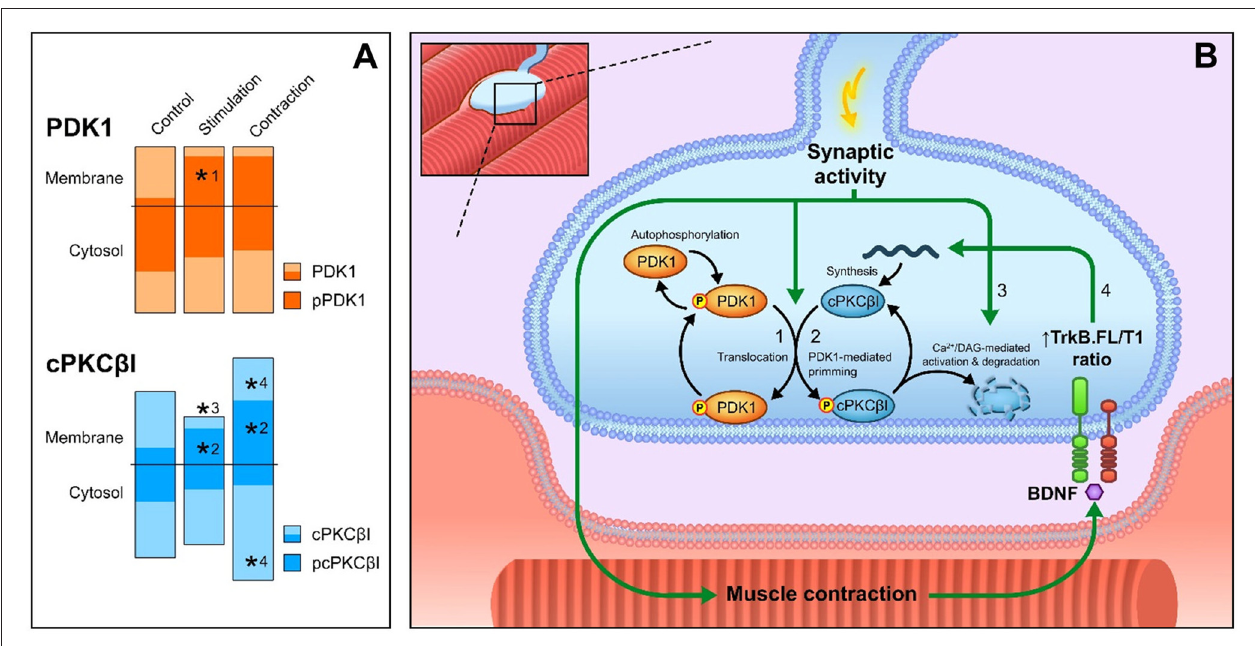
FIGURE 7 | Overview of PDK1 function and cPKC β I phosphorylation at the NMJ. (A) Summary of the results of this work. Columns represent the total protein levels of PDK1 (in orange), pPDK1 (in dark orange), cPKC β I (in blue) and pcPKC β I (in dark blue) in the membrane and cytosol compartments (indicated with a horizontal line) ∗ p < 0.05. (B) Proposed model of the action of PDK1 on cPKC β I phosphorylation at the NMJ. Total PDK1 protein and phosphorylation levels are maintained throughout all conditions. (#1) Synaptic activity induces the translocation of pPDK1 to the membrane. Consistent with the increased pPDK1 in the membrane, synaptic activity also (#2) increases the phosphorylation of cPKC β I in the same compartment. Once catalytically competent, pcPKC β I activation through synaptic activity (#3) reduces the total amount of cPKC β I in the membrane due to an increase in its activation-induced degradation. Muscle contraction (#4) increases the total amount of cPKC β I in both cytosol and membrane, suggesting an activation of its synthesis. In previous work, we determined that this enhancement is retrogradely regulated through BDNF/TrkB signaling (Hurtado et al., 2017). After muscle contraction, PDK1 activity remains unaltered and, therefore, pcPKC β I levels increase in concordance with total cPKC β I (#2). Abbreviations: phosphoinositide-dependent kinase 1; pPDK1, phosphorylated phosphoinositide-dependent kinase 1; cPKC β I, conventional protein kinase C β I; pPKC β I, phosphorylated conventional protein kinase C β I; BDNF, brain-derived neurotrophic factor; TrkB.FL, tropomyosin-related kinase B full-length, TrkB.T1, tropomyosin-related kinase B truncated isoform